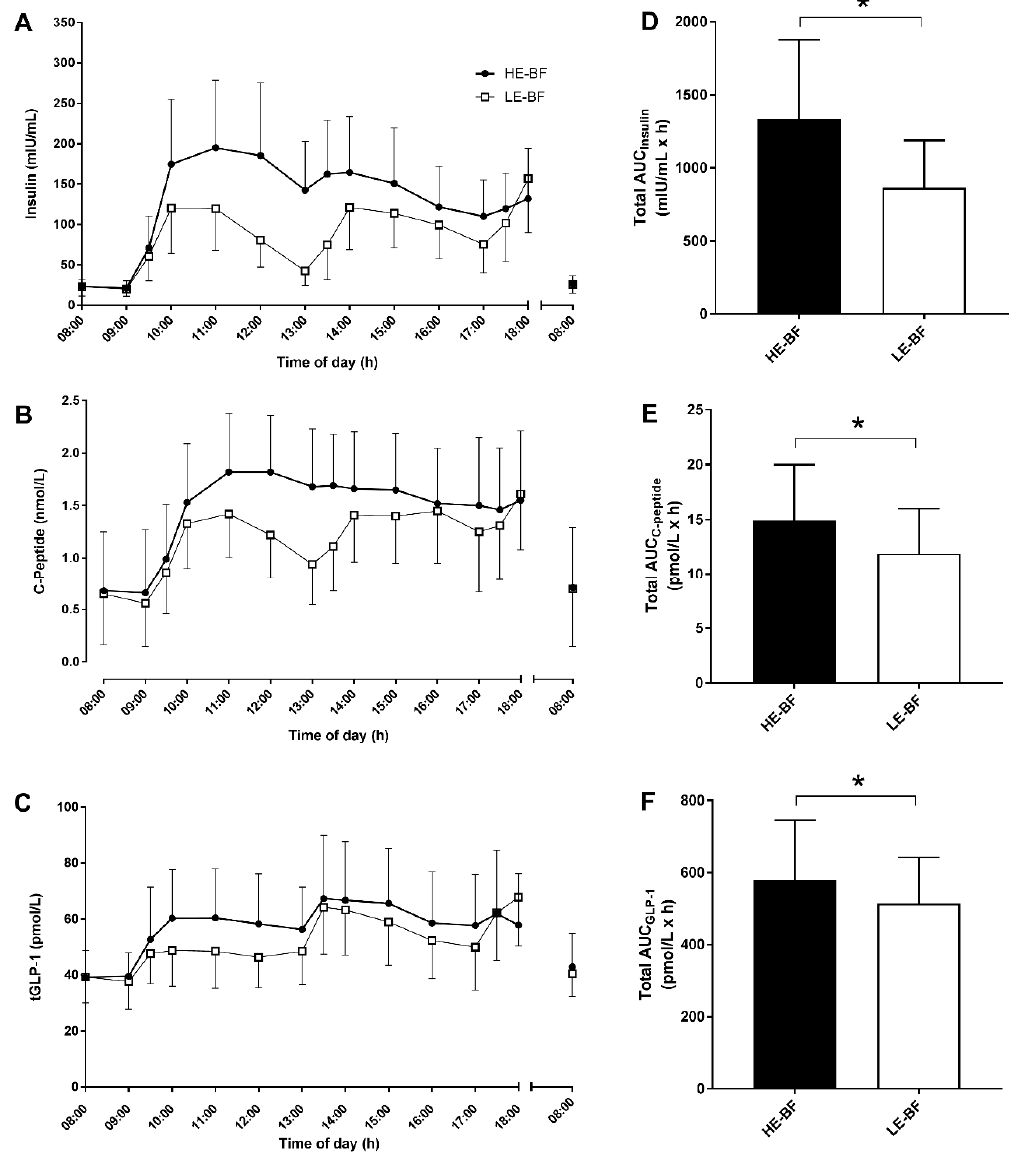
Figure 4. Plasma hormone concentrations of Insulin ( A ), C-peptide ( B ), and tGLP-1 ( C ), from participants with prediabetes ( n = 13) throughout (08:00–18:00 h) trial conditions (high-energy breakfast (HE-BF; black bars and symbols) and low-energy breakfast (LE-BF; white bars and symbols)) and the morning after (08:00 h); and the associated total AUC (08:00–17:00 h) for insulin ( D ), C-peptide ( E ) and tGLP-1 ( F ). Data are mean ± SD. From LMM analyses, * significantly different ( p < 0.01) between conditions.